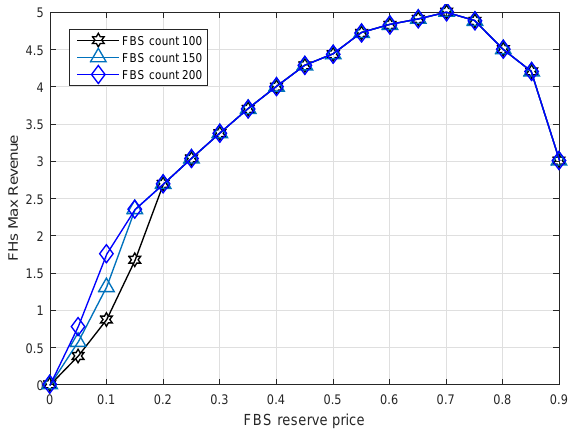
Figure 12. The max revenue of FHs versus FBS reserve price under different FBS